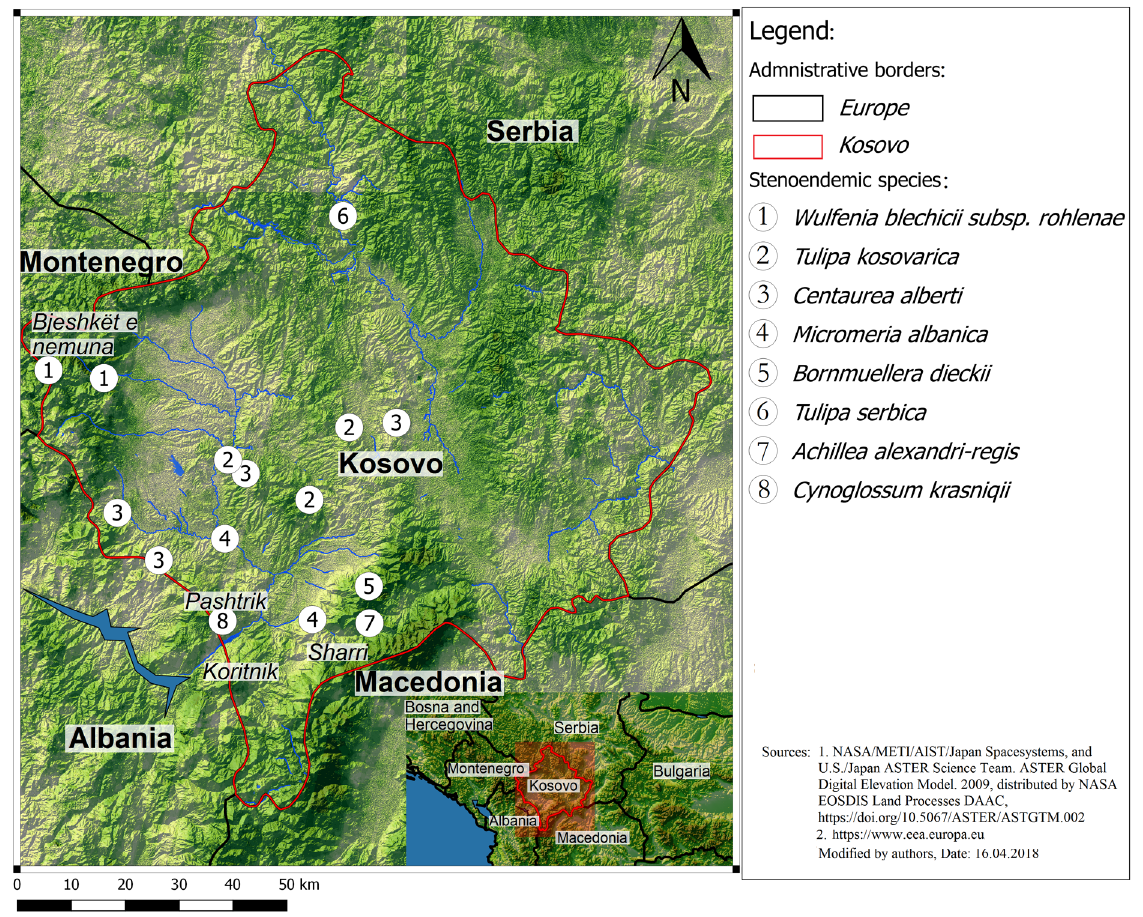
Figure 2: Stenoendemic species and subspecies in